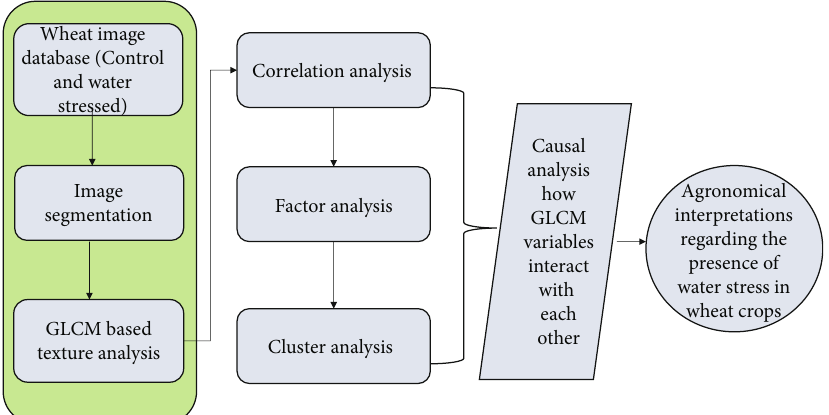
Figure 1: Flow chart of study methodology.